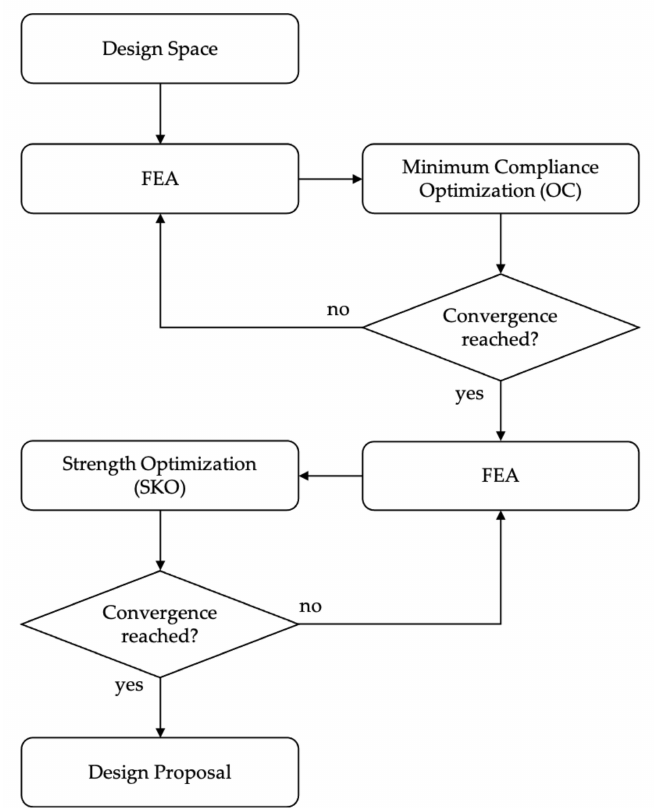
Figure 2. Conceptual procedure of the topology optimization for stiffness and strength (TOSS)